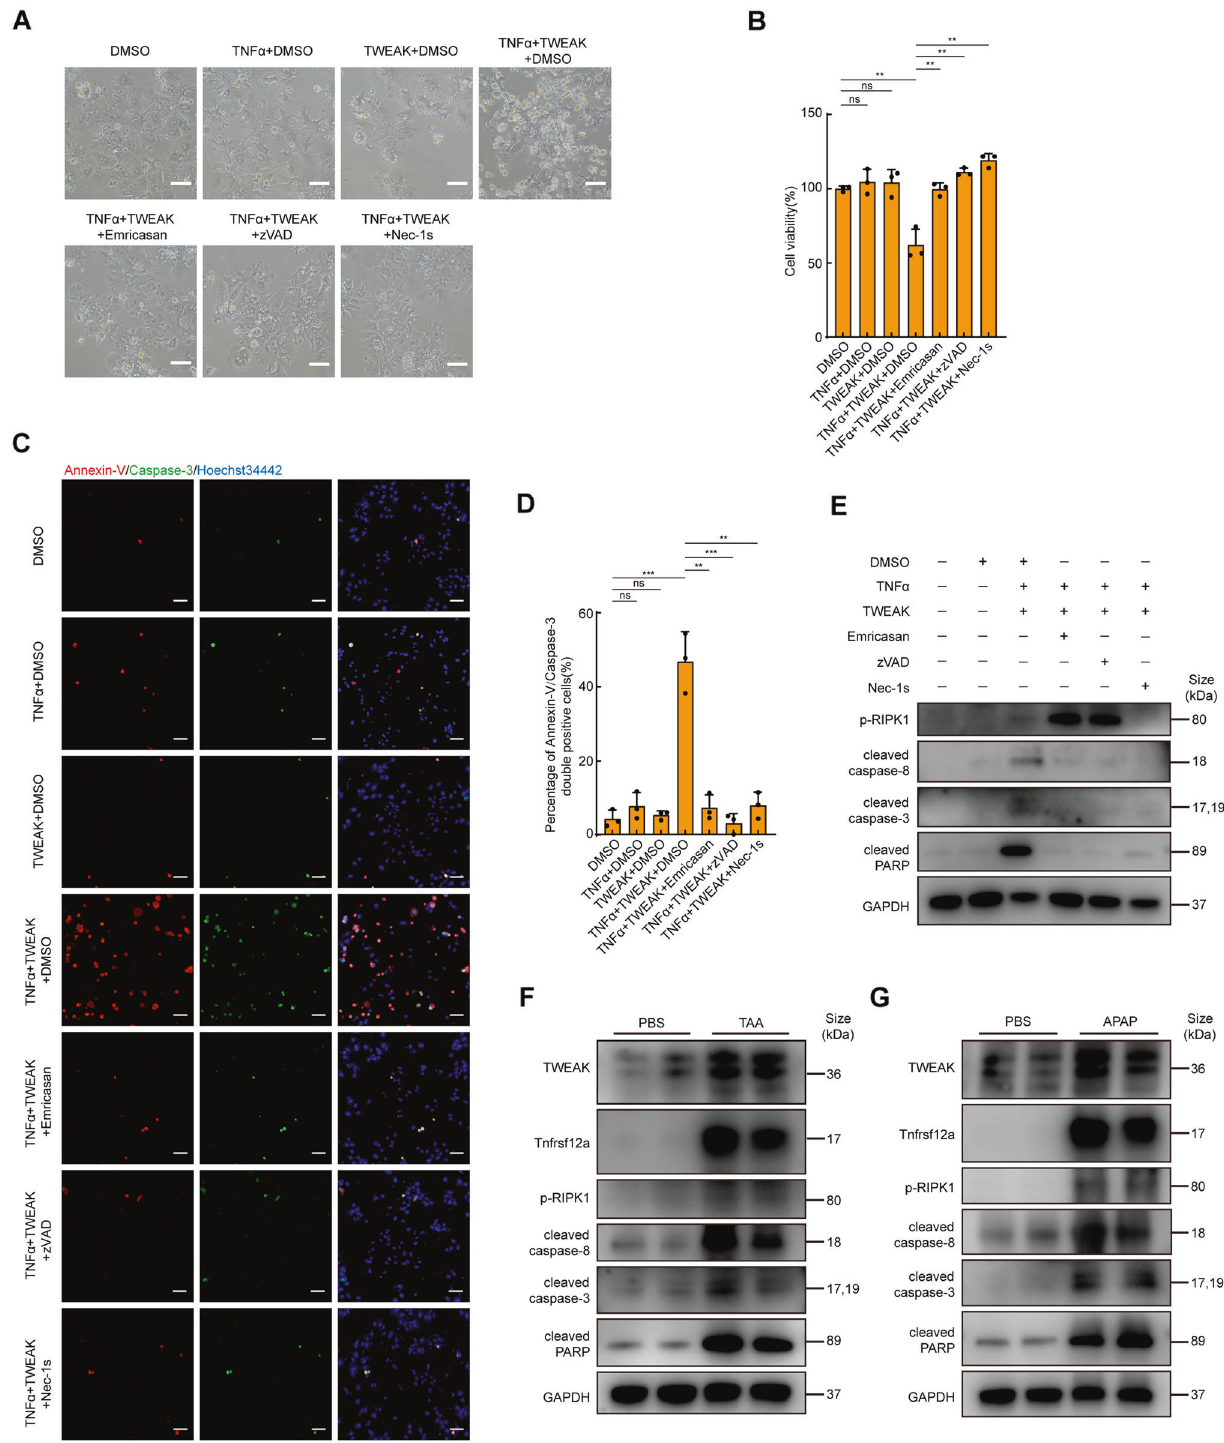
Fig. 3 TWEAK/Tnfrsfs12a axis induces RIPK1-dependent apoptosis in a proin fl ammatory environment in hepatocytes. A Morphology of hepatocytes following TWEAK and TNF α stimulation at 24 h in the presence or absence of cell death inhibitors. Scale bar, 100 μ m. B Quanti fi cation of cell viability of A ( n = 3; mean ± s.d.). P values were determined by Student ’ s t test (** P < 0.01; ns, not signi fi cant). C Assessment of Annexin-V/Caspase-3 double positive cells stimulated following TWEAK and TNF α stimulation at 24 h. Scale bar, 100 μ m. D Percentage of Annexin-V/Caspase-3 double positive cells of C ( n = 3; mean ± s.d.). P values were determined by Student ’ s t test (** P < 0.01; *** P < 0.001; ns, not signi fi cant). E Expression of phospho-RIPK1 (p-RIPK1), cleaved caspase-8, cleaved caspase-3, and cleaved PARP of hepatocytes were analyzed with corresponding antibodies following TWEAK and TNF α stimulation at 12 h. GAPDH was used for normalization. F , G Immunoblotting analysis of whole liver lysates following TAA or APAP treatment at 24 h with corresponding antibodies, n = 2 per group. GAPDH was used for normalization. All experiments were repeated at least two